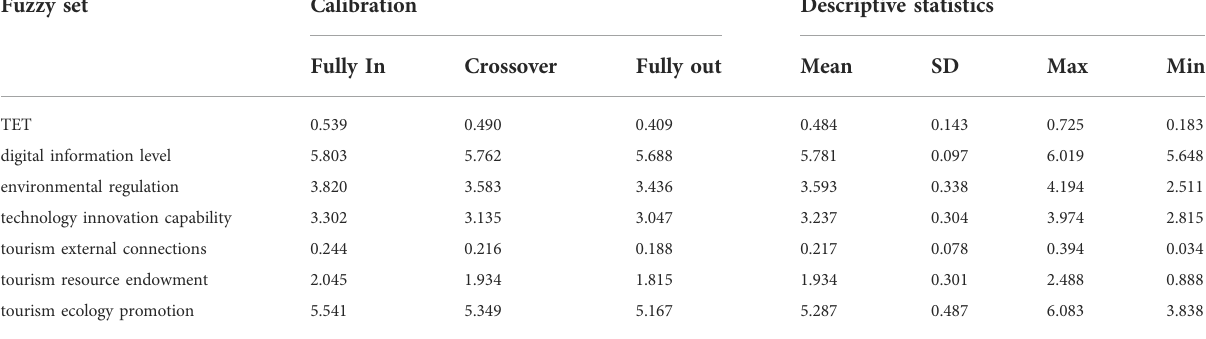
TABLE 2 Calibration and Descriptive Statistics of antecedent condition. Fuzzy